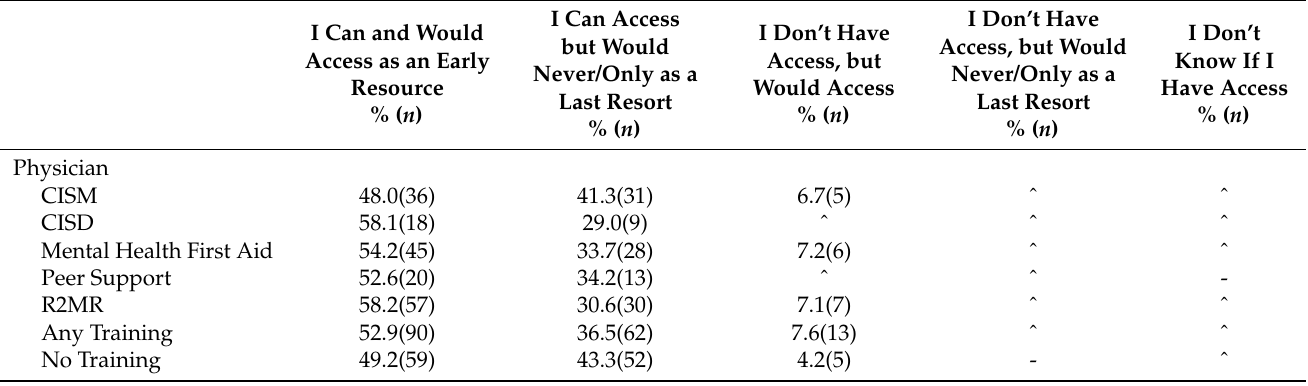
Table 1. Prevalence of mental health training categories and attitudes toward accessing professional mental health